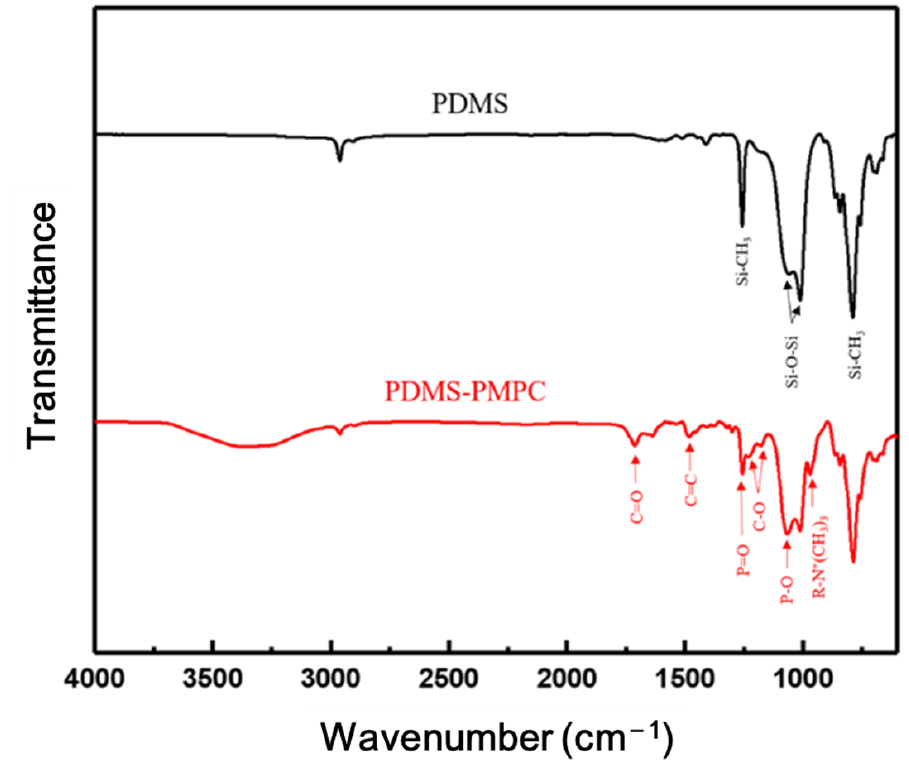
Figure 8. FTIR spectrum of PDMS and MPC polymer brushes (PMPC) were grafted on the PDMS substrate and PDMA-PMPC substrate.